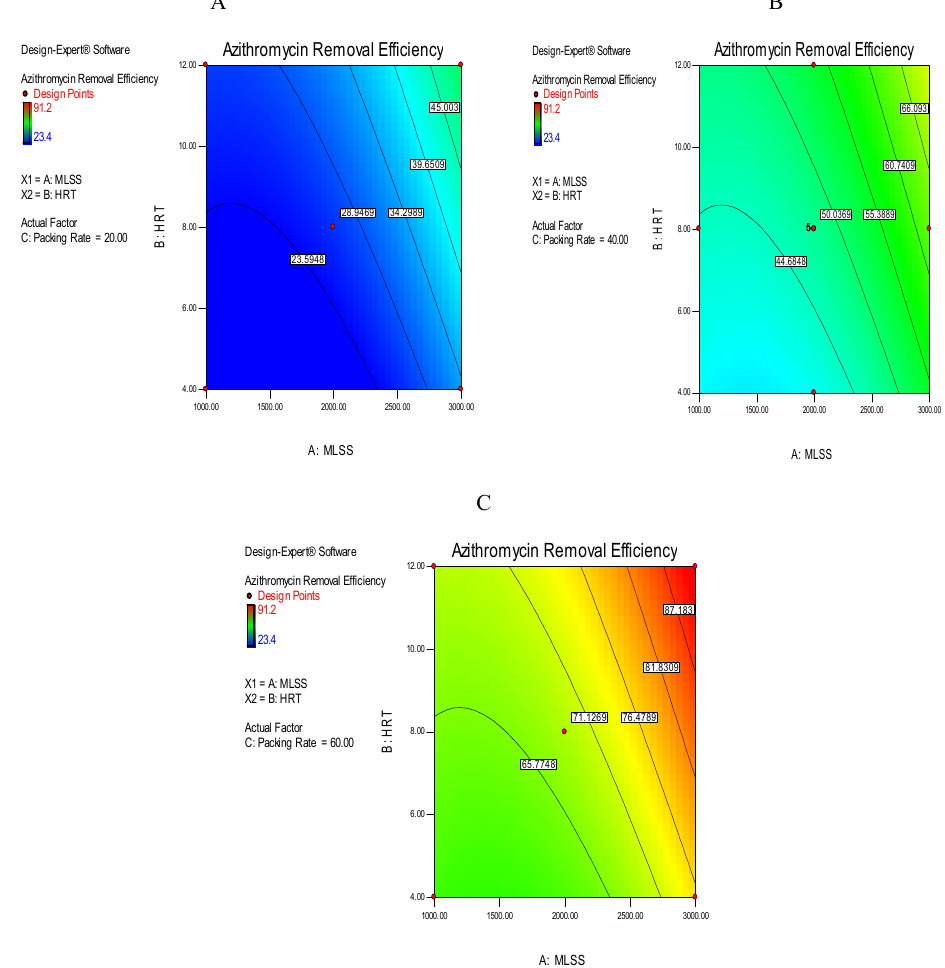
Fig. 4. Removal efficiency of azithromycin with packing rates of A) 20%, B) 40%, and C) 60% using combined system of UV/H 2 O 2 process and MBBR